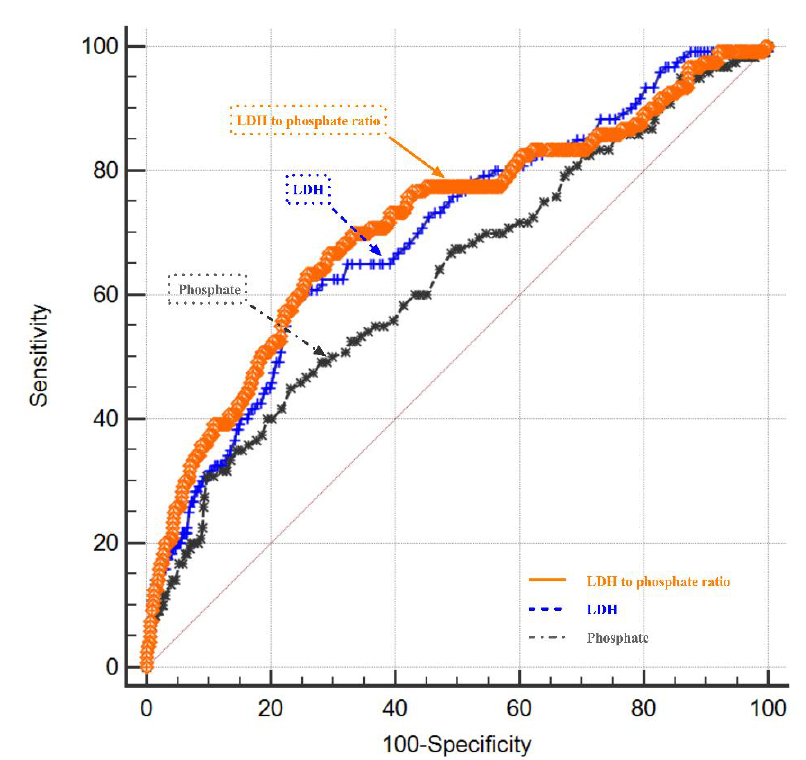
Figure 6. ROC curve of the three predictors. Predictive values of LDH-phosphate Ratio for 3-month modified Rankin Scale (mRS) >2 area under curve 0.713 (the cutoff = 226.25, 95% CI, 0.681–0.743; p < 0.001; the sensitivity was 63.33%, and the specificity was 74.18%). The AUC of LDH and phosphate were 0.698 (95% CI 0.666–0.729, p < 0.001; the sensitivity was 59.17%, and the specificity was 75.95%), 0.630 (95% CI 0.597–0.662, p < 0.001; the sensitivity was 45.00%, and the specificity was 76.77%), respectively.